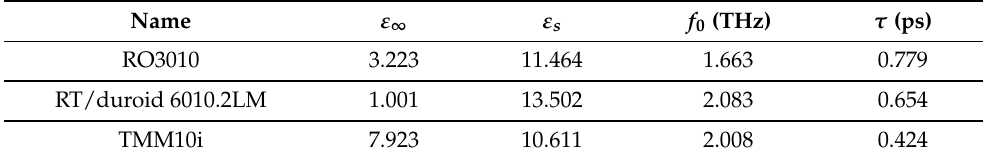
Figure 4. Relative dielectric permittivity, loss tangent, and comparison between measured and simulated spectra based on the Lorentz-fitted permittivities of the three investigated substrates: ( a ) RO3010, ( b ) RT/duroid 6010.2LM, and ( c ) TMM10i. The insets in the second column show photos of the characterized samples with an area of approximately 5 × 5 cm 2 . In ( a ), results are compared to the data provided in [11]. Table 2. Lorentz model parameters calculated for the investigated Rogers high-permittivity